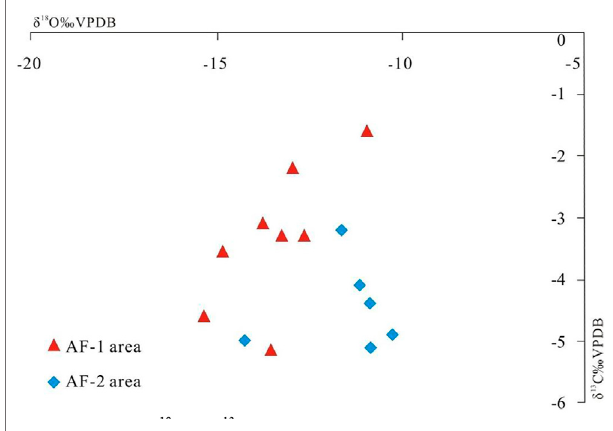
FIGURE 12 | Scatter diagram of δ 18 O vs. δ 13C for calcite cements in the Huangliu sandstones.